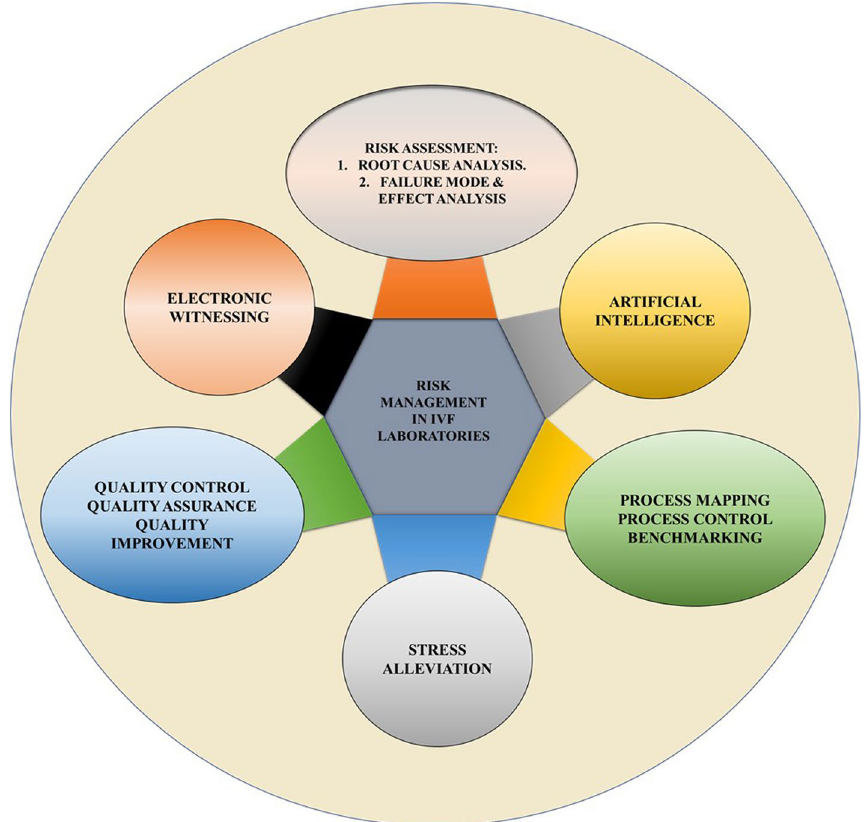
Fig. 4 Risk management programmes and technologies for tackling errors in the IVF laboratory. Artificial intelligence and electronic witnessing system are innovative technologies introduced in IVF to help optimize procedural efficiency, reduced complacency, and minimize errors. Root cause analysis, failure mode and effect analysis, total quality management activities in the laboratory, and stress reduction (minimizing workload) are essential programmes for minimizing the risk of errors in IVF